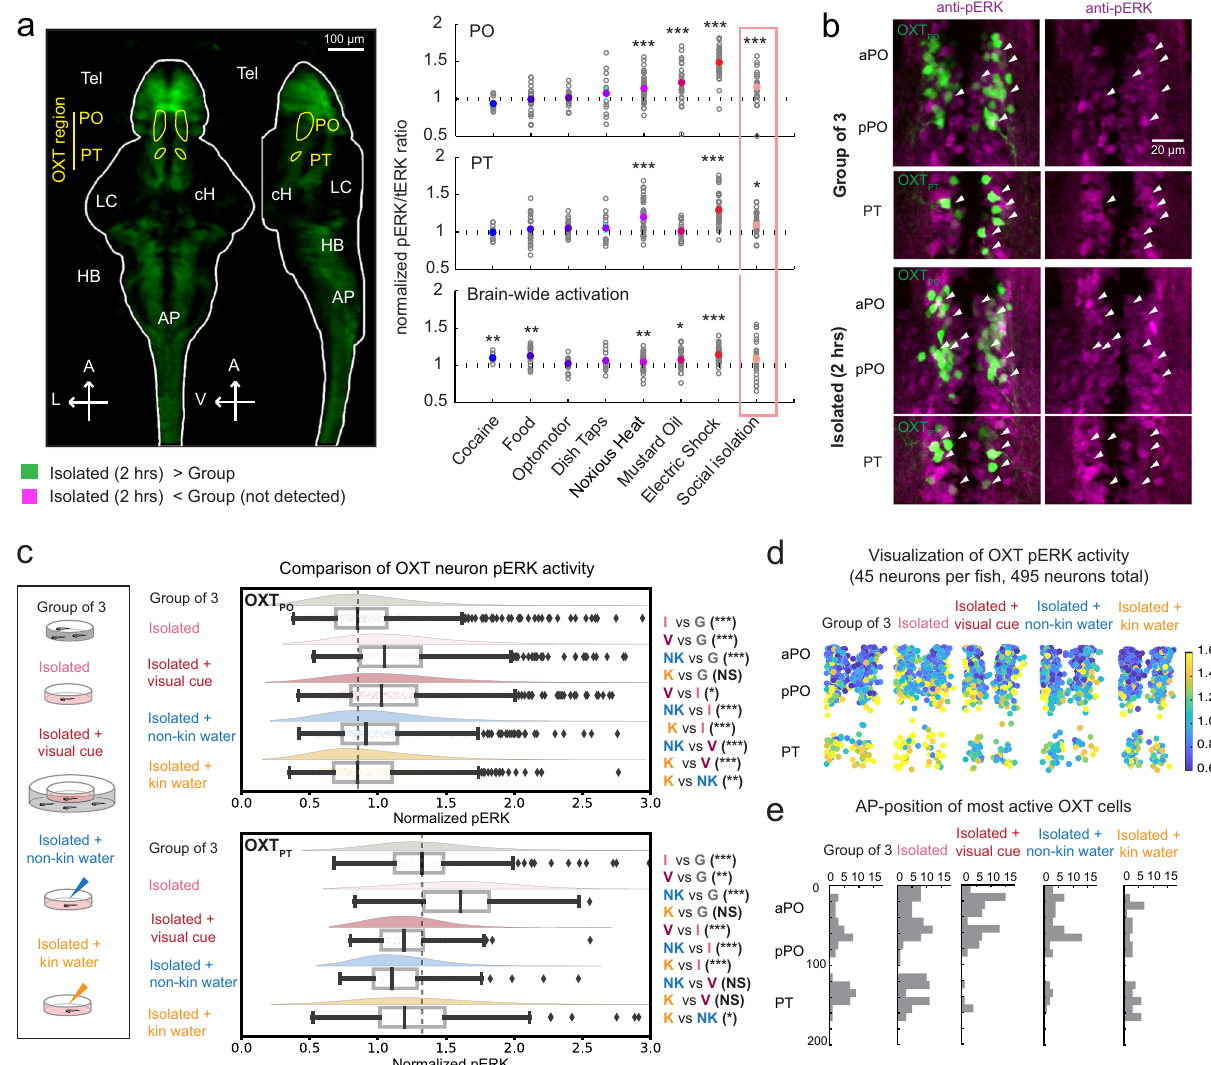
Fig. 1 Phospho-ERK-based mapping reveals OXT neuron modulation by social context. a Left: MAP-mapping 22 of 2-hr isolated fi sh vs fi sh in groups. Green voxels indicate signi fi cantly higher activity. Map combines data from 5 experiments in which isolated fi sh are compared with groups of 3 (2 experiments), 5 (1 experiment), or 10 (2 experiments). Yellow = outline of preoptic (PO) and posterior (PT) OXT populations used to quantify activity in Right. Tel = telencephalon, cHcaudal hypothalamus, LClocus coeruleus, AParea postrema, HBhindbrain. Aanterior, Lleft, Vventral. Scale bar = 100 µ m. Right: Social isolation signi fi cantly activates PO and PT regions. Data for other stimuli were also included in Wee et al. (2019) 6 . Adjusted p-values for social isolation: *** p = 0.00084 (PO), * p = 0.03 (PT), p = 0.42 (whole brain), two-sided Wilcoxon signed-rank test relative to a median of 1, Bonferroni correction. b Maximum-intensity projection images showing pERK expression (magenta) in Tg(oxt:GFP) -positive (green) and surrounding neurons, from a representative dissected brain of an isolated fi sh (bottom) and a fi sh kept in groups of 3 (top). White arrows indicate examples of OXT neurons with high pERK intensities. Scale bar = 20 µ m. This experiment was repeated more than 5 times with similar results. c Fish were either kept in groups of 3 (gray, n = 835 OXT PO /158 OXT PT neurons from 12 fi sh), isolated (pink, n = 803 OXT PO /128 OXT PT neurons from 11 fi sh), isolated but exposed to visual cues of conspeci fi cs (red, n = 796 OXT PO /106 OXT PT neurons from 12 fi sh), or isolated but exposed to non-kin-conditioned water (blue, n = 751 OXT PO /115 OXT PT neurons from 11 fi sh) or kin- conditioned water (orange, n = 722 OXT PO /134 OXT PT neurons from 11 fi sh). Boxplot shows the median (center), interquartile range (IQR; box), 1.5 IQRs of the lower and upper quartile (whiskers), and outliers beyond this range (diamonds); Half-violin plot shows kernel-density estimate of normalized pERK values. OXT PO neurons: adjusted p = 0*** (group vs isolated)/0*** (group vs visual)/1.7×10 − 4 *** (group vs non-kin water)/1 (group vs kin water)/0.023* (isolated vs visual)/3.4×10 − 18 *** (isolated vs non-kin water)/0*** (isolated vs kin water)/4.8×10 − 8 *** (visual vs non-kin water)/4.2×10 − 22 ***(visual vs kin water)/ 0.0014** (kin vs non-kin water). Kruskal – Wallis Test with Tukey – Kramer correction for multiple comparisons. OXT PT neurons: adjusted p = 7.9×10 − 6 *** (group vs isolated)/0.0071** (group vs visual)/4.3×10 − 6 *** (group vs non-kin water)/0.20 (group vs kin water)/1.1×10 − 13 *** (isolated vs visual)/6.8×10 − 21 *** (isolated vs non-kin water)/1.0×10 − 10 *** (isolated vs kin water)/0.58 (visual vs non-kin water)/0.69 (visual vs kin water)/0.032* (kin vs non-kin water). Kruskal – Wallis test with Tukey – Kramer correction for multiple comparisons. d Spatial distribution of OXT neurons from each category, color coded according to normalized pERK intensity (most active = yellow, least active = deep blue, colorbar shows normalized pERK value). See Methods. e Anterior – posterior (AP) localization of “ active cells ” sampled from each category. See Methods. Source data are provided as a Source Data fi le.